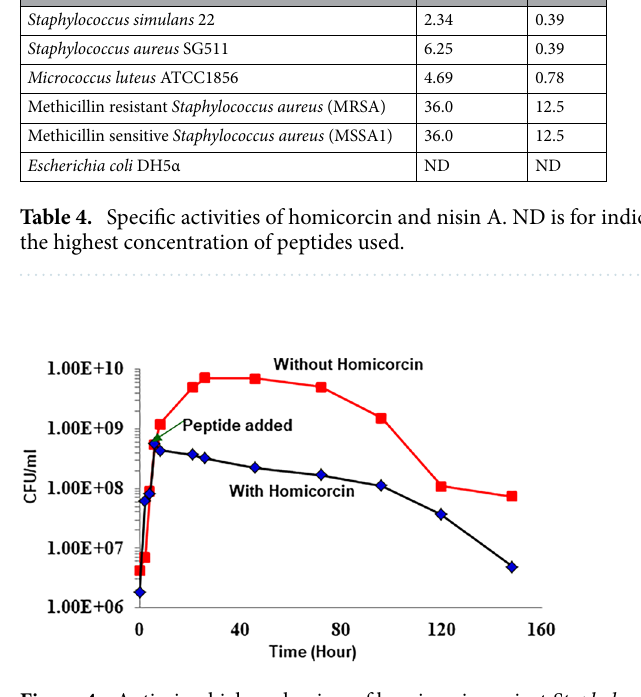
Figure 4. Antimicrobial mechanism of homicorcin against Staphylococcus simulans 22. Growth inhibition of Staphylococcus simulans 22 was measured as colony forming unit (CFU) count per ml for 148 h in both peptide treated and untreated samples. 8XMIC of homicorcin peptide was applied at mid-log